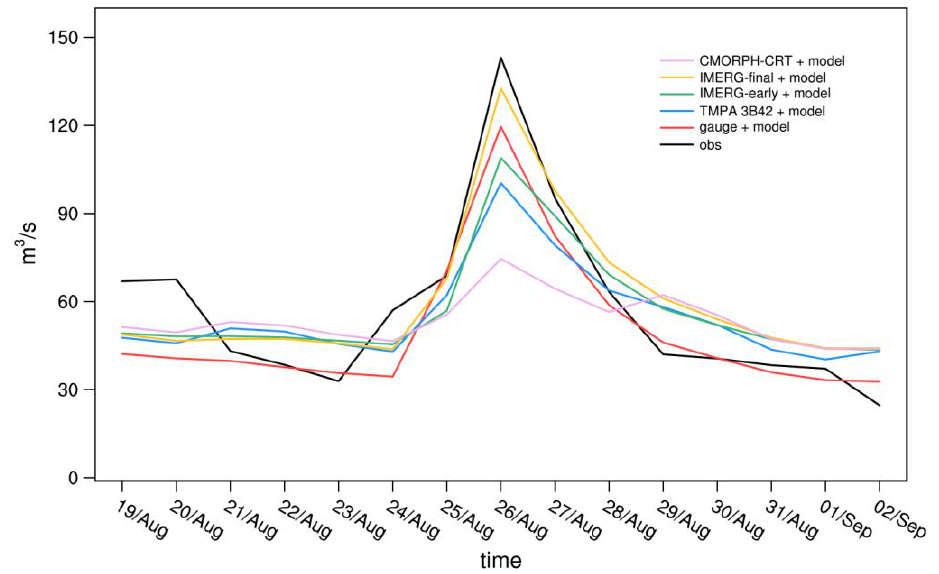
Figure 10. Daily time-series between 19 August 2019 and 22 September 2019 of mean streamflow in the rainfall center.